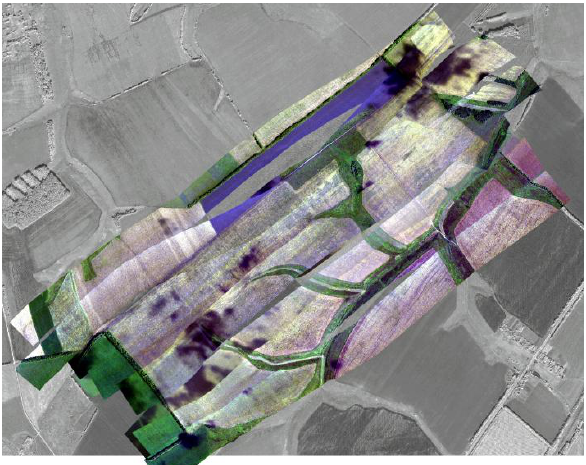
Image 5. All corrected images from the first series combined into a mosaic image.